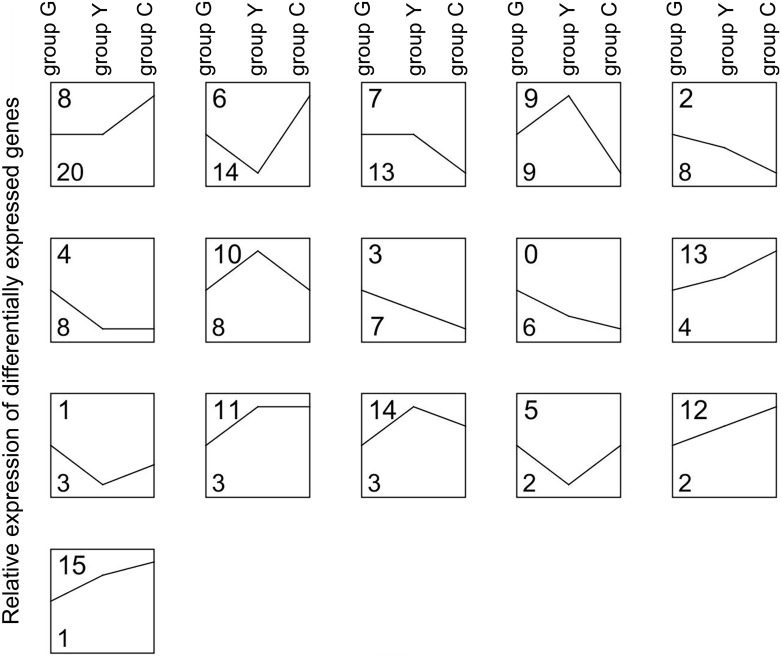
Series-cluster analysis of differentially expressed genes (DEGs) during growth in goats at different postnatal stages using STEM software.The significant level was set at 0.05 and the minimum correlation at 0.7; the “maximum number of model profiles” was set at 20 and the “maximum unit change in model profiles between time points” was set at 2. group G, kid goats; group Y, young goats; group C, adult goats. The number in the top left-hand corner of a profile box is the pattern ID number. The number in the lower left corner of the profile box is the number of genes.